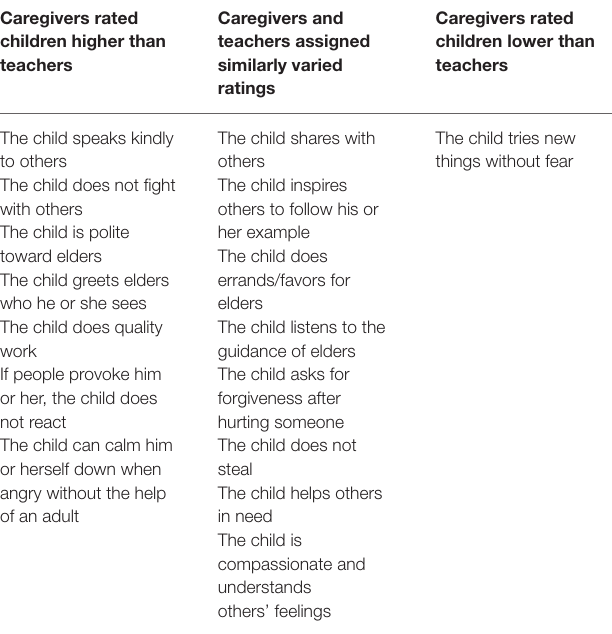
TABLE 10 | Comparison of teacher and caregiver responses by item. Caregivers rated children higher